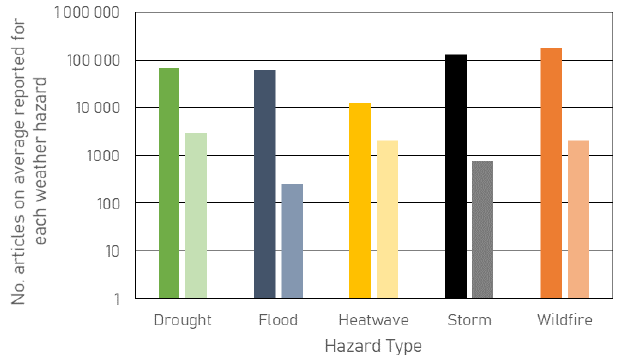
Figure 4. The average number of articles per individual hazard cat- egory for the last 5 years. Dark colour is total number of articles and light colour is articles including climate change. (Number of articles in Fig. 2a or b/total recorded hazards for each hazard type in Fig.